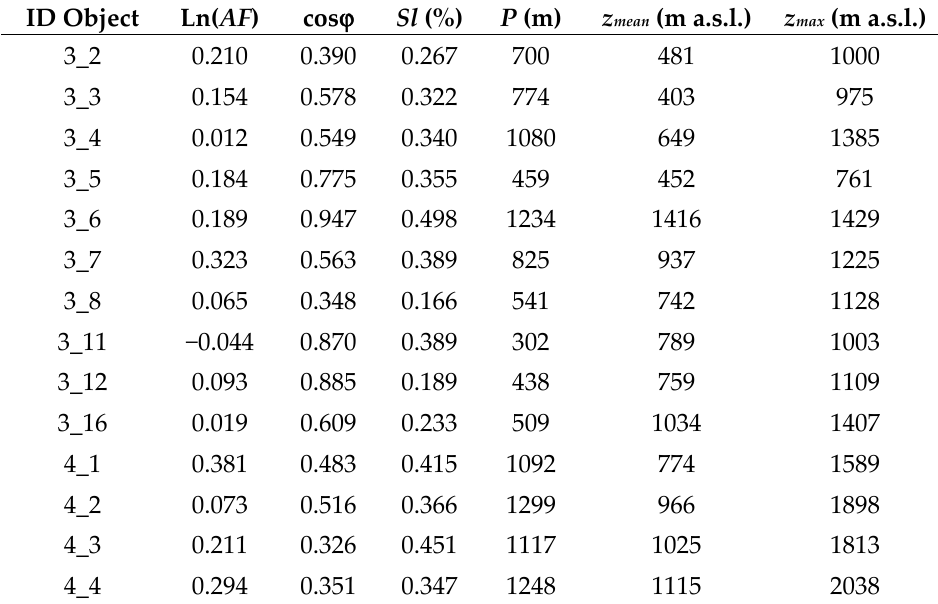
Table 4. Values of ln( AF ) and topographic indices for each orographic object.